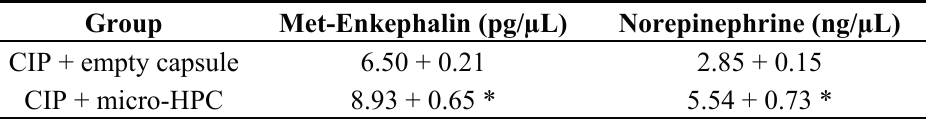
2. The concentration of met-enkephalin and norepinephrine in the CSF (cerebrospinal